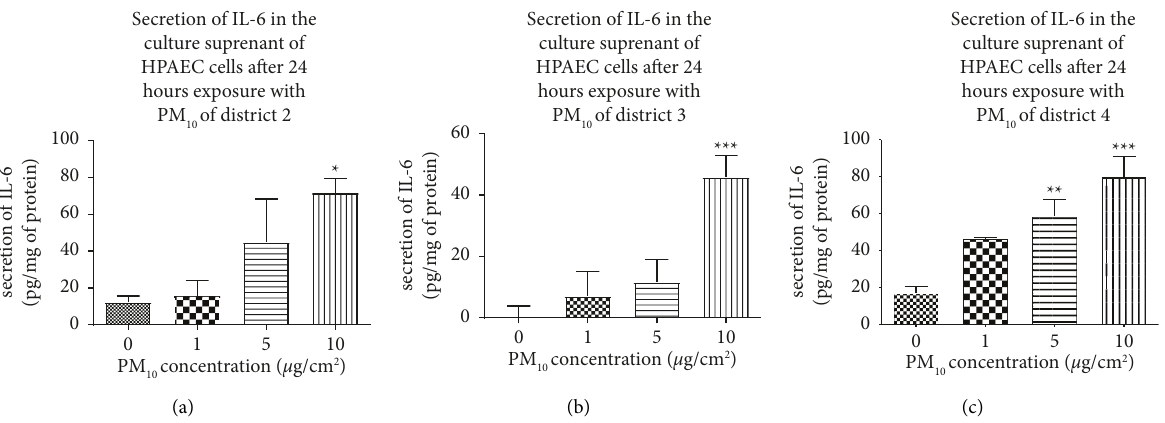
Figure 3: Secretion of the proinflammatory cytokine IL-6 in HPAEC cells after 24 hours of exposure to PM 10 from districts 2 (a), 3 (b), and 4 (c) of Ouagadougou (Burkina Faso). HPAEC cells were seeded for 24 hours and then treated with different concentrations of PM10 (1, 5, and 10 µ g/cm2) for 24 hours. The IL-6 concentration (pg/mL) was determined by using the ELISA technique and measured by spectro- photometry. This concentration was then related to total protein levels for each well (pg/mg). Data are expressed as the mean ± SEM of three independent experiments n � 3 (three wells/concentration). The test used is a one-way ANOVA followed by a multiple comparison with Dunnett’s correction ∗ p < 0 . 05: Significance level compared to control